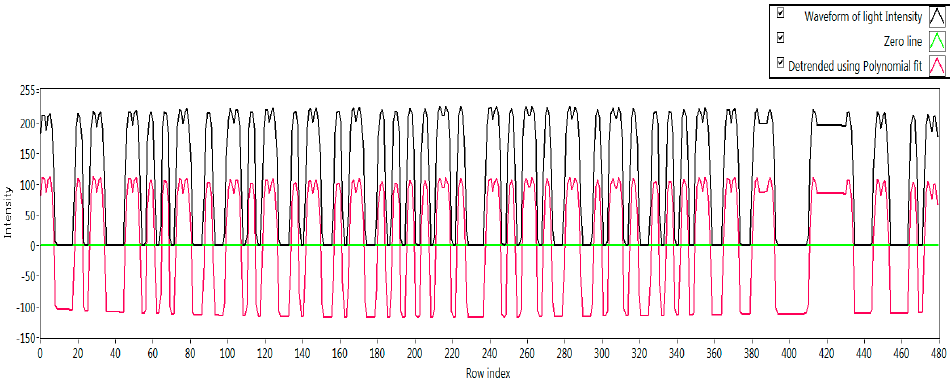
Figure 12. An experimental result in asynchronous decoding under mismatched frame rates.